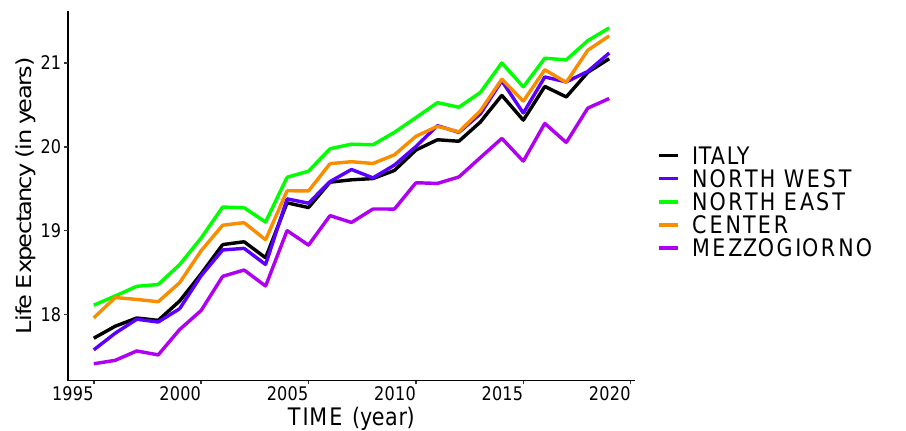
Figure 2. Life Expectancy at age 65 by geography (NUTS-1 level) in Italy during 1995–2019. Source: ISTAT.